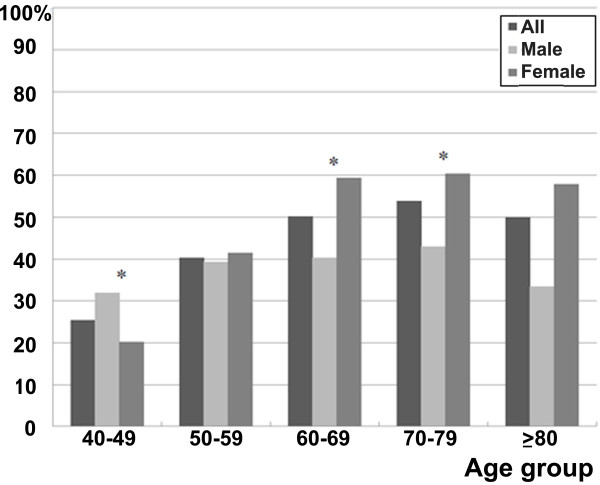
Prevalence of MetS according to age groups. *P value < .050 by Chi square test or Fisher’s exact test between male and female subjects. MetS = metabolic syndrome.